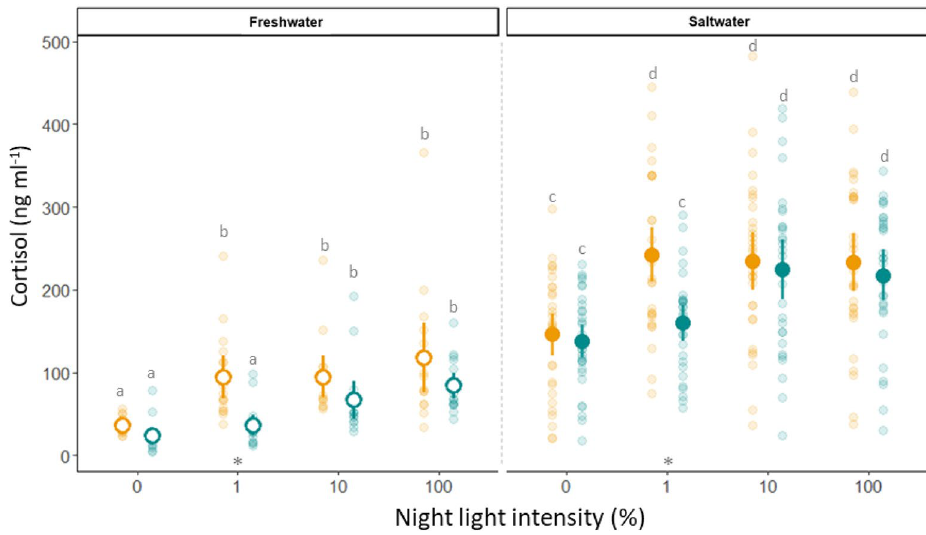
Figure 4. Impact of light treatment and saltwater challenge on cortisol. Plasma cortisol concentrations after 22 days of exposure to light treatments. Open points display the means ± 95% confidence intervals of GLMMs from control samples collected in freshwater, while solid points display the means ± 95% confidence intervals after 24 h acute exposure to 34.5 ppt saltwater. Faded points present individual measurements. High light intensity groups are presented in orange, while the low light intensity groups are presented in green. Significant differences between treatments within salinity groups are indicated by different lower-case letters.